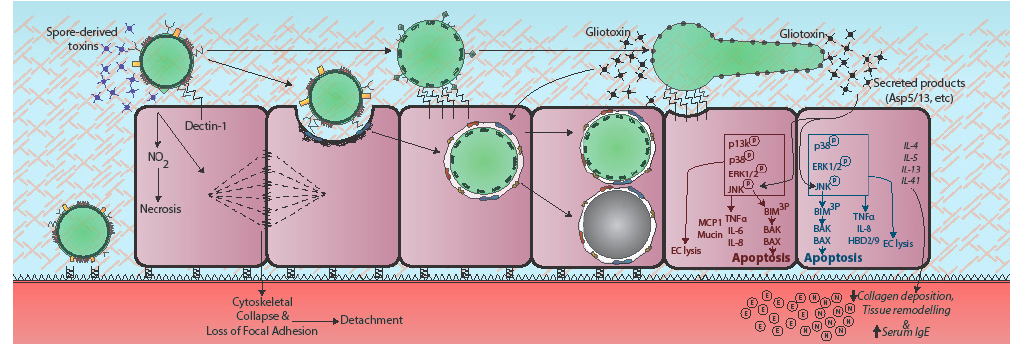
Figure 2. Epithelial responses to A. fumigatus. Epithelial responses to A. fumigatus vary dramatically according to fungal morphotype and host cell origin, the latter denoted in red for alveolar epithelial cells and blue for bronchial epithelial cells. Contact with A. fumigatus spores prompts rapid cytoskeletal reorganisation and loss of focal adherence, possibly via spore-associated toxins [35]. In bronchial epithelial cells recognition of germinating conidia and hyphae leads to upregulation of Dectin-1 expression at the host cell membrane and phosphorylation-mediated activation of phosphatidylinositol3-kinase (PI3K), mitogen activated protein kinase (MAPK) p38 and ERK1/2 signalling, leading to TNF α , IL-8, and β -defensin expression (HBD-2 and -9) [36–38]. In AECs, challenge with A. fumigatus culture filtrate prompts MAPK ERK1/2, p38, and c-Jun N-terminal protein kinases (JNK) phosphorylation, in a partially fungal protease-dependent manner, leading to lytic death of the host cell [39,40]. JNK or p38 inhibitors protect against host damage [39]. The secreted products of cultured A. fumigatus also elicit remodelling of the respiratory epithelium involving heightened expression of classical Th2 cytokines (IL-4, IL-5, IL-13), serum IgE, collagen deposition, and neutrophil (N) and eosinophil (E) recruitment [41]. Gliotoxin exposure induces cytoskeletal collapse, cell peeling, and apoptosis. Gt activates the JNK pathway leading to apoptosis. JNK triple-phosphorylates the pro-apoptotic protein Bim, leading to pro-apoptotic Bak and Bax activation, mitochondrial membrane permeabilization, and apoptosis [42–45]. Italicised text indicates responses observed in whole animals or